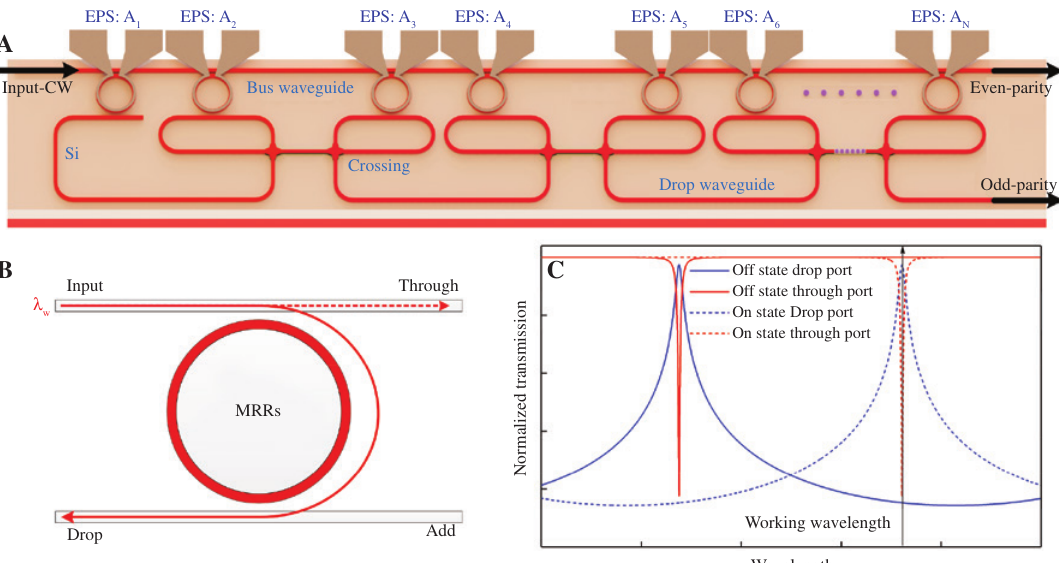
Figure 1: Schematic of the proposed device and switching element. (A) Schematic of the proposed optical parity checker (CW, continuous wave; MRR, micro-ring resonator; EPS, electrical pulse sequences; N, an odd number). (B) The path of light in the MRR at ON state (the solid line) and OFF state (the dotted line). (C) Normalized transmissions at the drop and through ports. The black solid line indicates the working